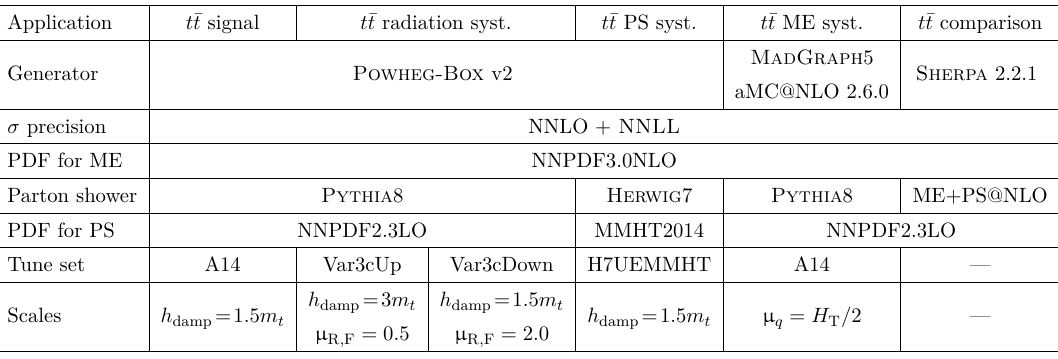
Table 1 . Summary of t ¯ t MC samples used in the analysis, showing the generator for the hard- scattering process, cross-section σ normalisation precision, PDF choices for the hard-process matrix element (ME) and parton shower (PS), as well as the parton shower and hadronisation generator and the corresponding tune sets and